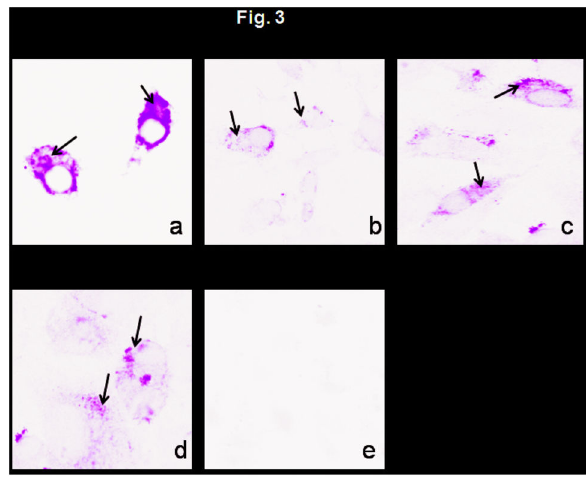
Figure 3. Immunofluorescence of Env protein expressed in Vero cells infected with rLaSota/gp160 (panel a), rLaSota/gp140L (panel b), rLaSota/gp140S (panel c), rLaSota/gp120 (panel d) and rLaSota (panel e) at an MOI of 0.1 PFU. Twenty-four h post-infection, the infected cells were fixed with paraformadehyde and permeabilized with Triton X-100 for detection of total antigen inside the cell. The cells were probed with a pool of gp120-specific monoclonal antibodies followed by incubation with Alexa Fluor 488- conjugated goat anti-mouse IgG antibodies, and analyzed by immunofluorescence. The cells were visualized under Nikon Eclipse TE fluorescent microscope. Arrows indicate areas of positive immunofluorescence.